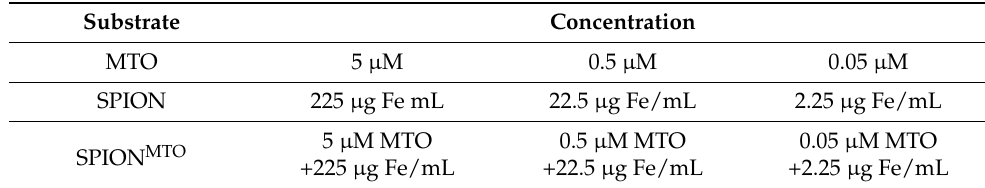
Table 1. Summary of the used